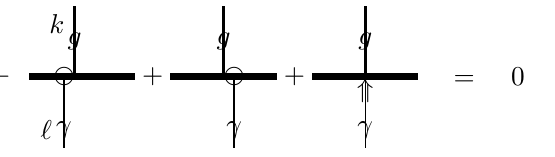
Figure 20 . The Ward identity for the photon in the presence of a graviton-scalar-scalar vertex.